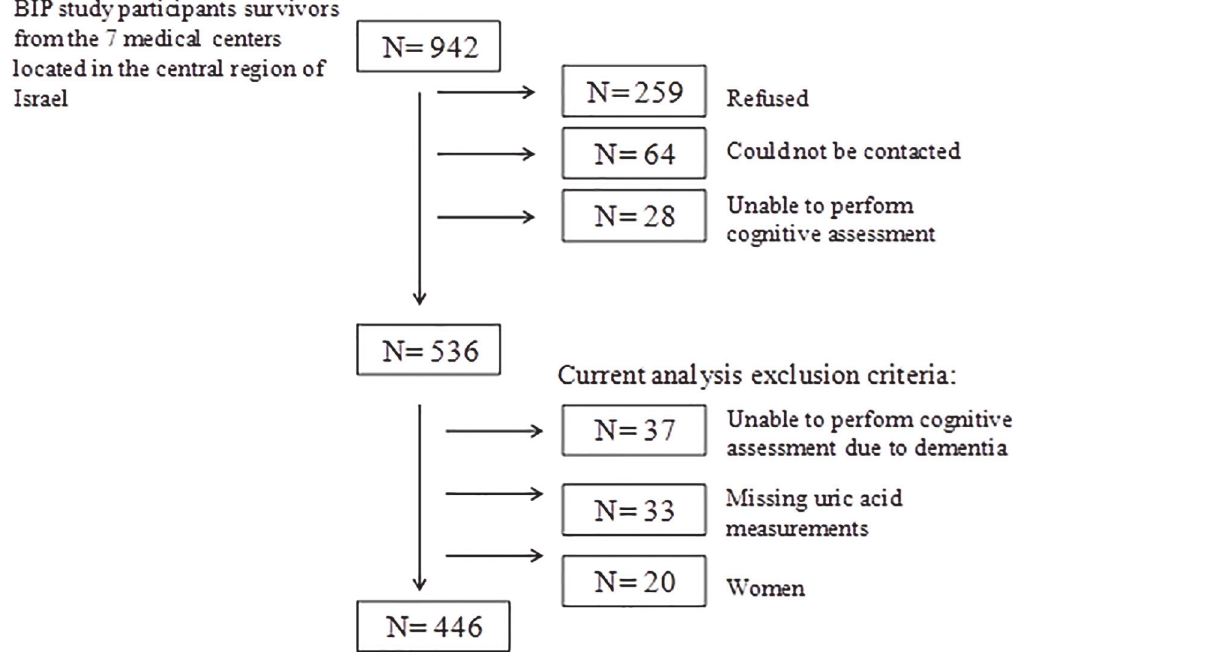
Fig 1. Flow diagram of study